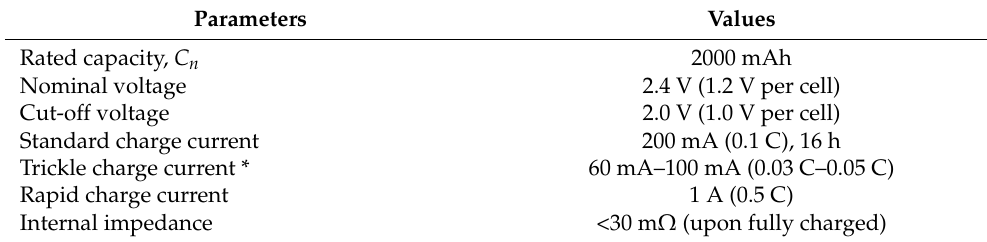
Table 1. Main characteristics of the analyzed battery pack of two cells from